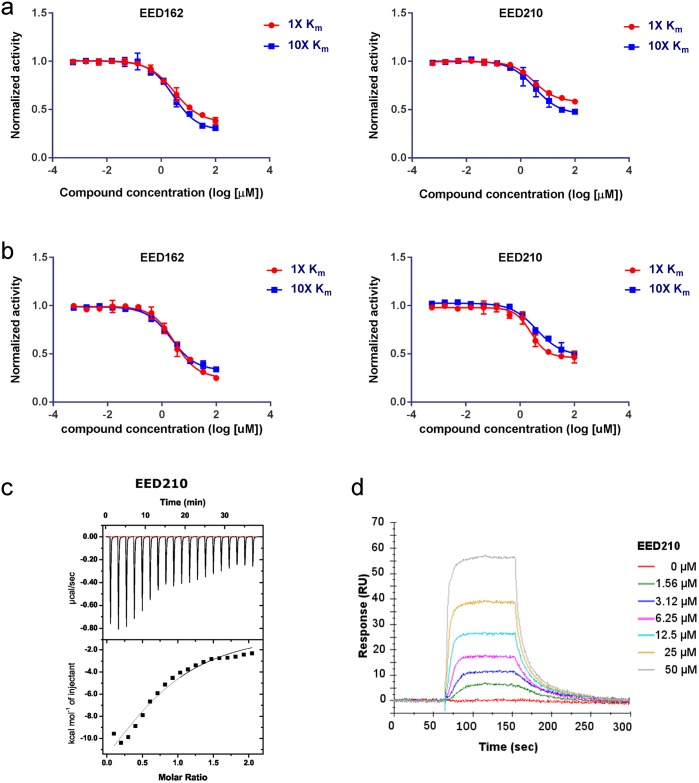
EED inhibitors are non-competitive with SAM or H3K27me0 peptide.a. EED inhibitors are non-competitive with SAM. Enzymatic assays were carried out at 1 x and 10 x SAM with H3K27me0 in excess. There is no IC50 shift when increasing SAM concentration. b. EED inhibitors are non-competitive with H3K27me0. Enzymatic assays were carried out at 1 x and 10 x H3K27me0 with SAM in excess. There is no IC50 shift when increasing H3K27me0 concentration. c. Binding affinity determination of EED210 to EED by ITC. The stoichiometry of binding between EED210 and EED was approximately 1:1 molar ratio with N = 0.78. The enthalpy change is -20.14 ±5.29 Kcal/mol and the entropy change is -46.5cal/mol/deg. d. Concentration dependent SPR analysis of EED210 binding to EED (residues 40–441).